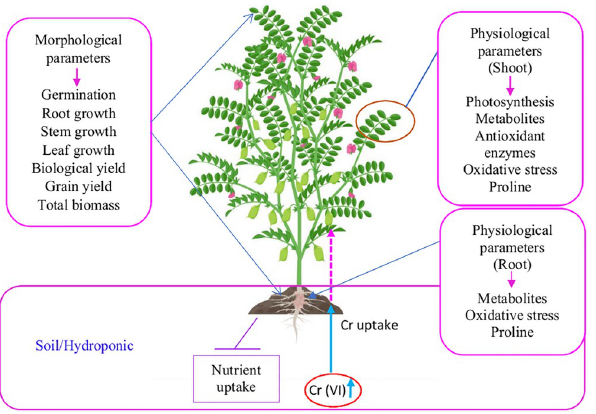
Fig 1. A schematic outlining of mechanism of chromium (Cr) toxicity in soil and the potential deleterious effects of Cr pollution on morphological and physiological aspects of chickpea